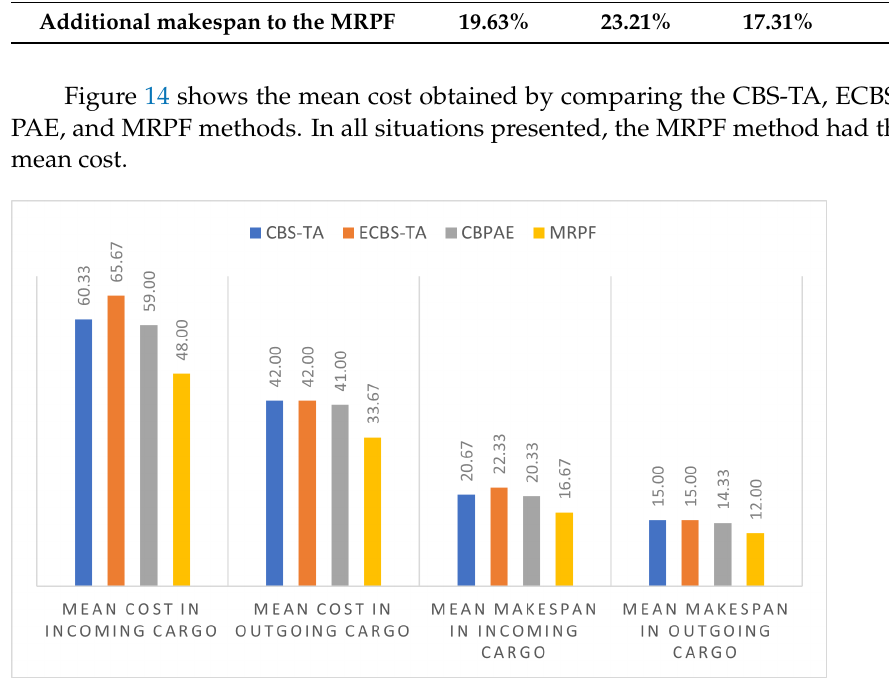
Figure 14. Graphical analysis of the comparison of MRPF with similar methods for Incoming Cargo and Outgoing Cargo